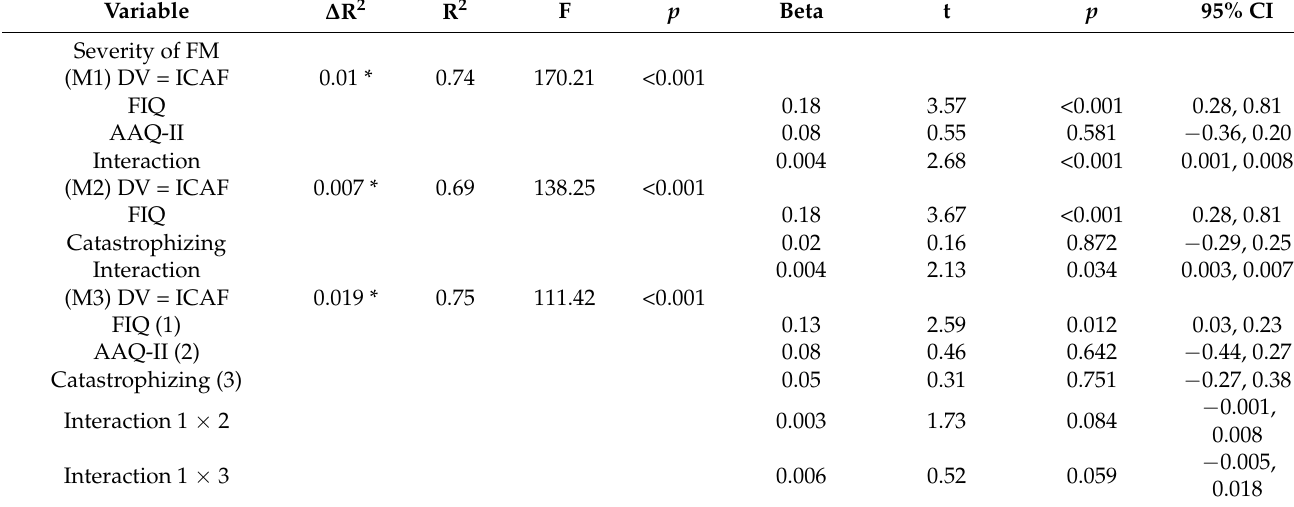
Table 4. Prospective prediction of severity of FM from impact of FM with several moderator variables (psychological flexibility, catastrophizing, and their interaction). ( N =